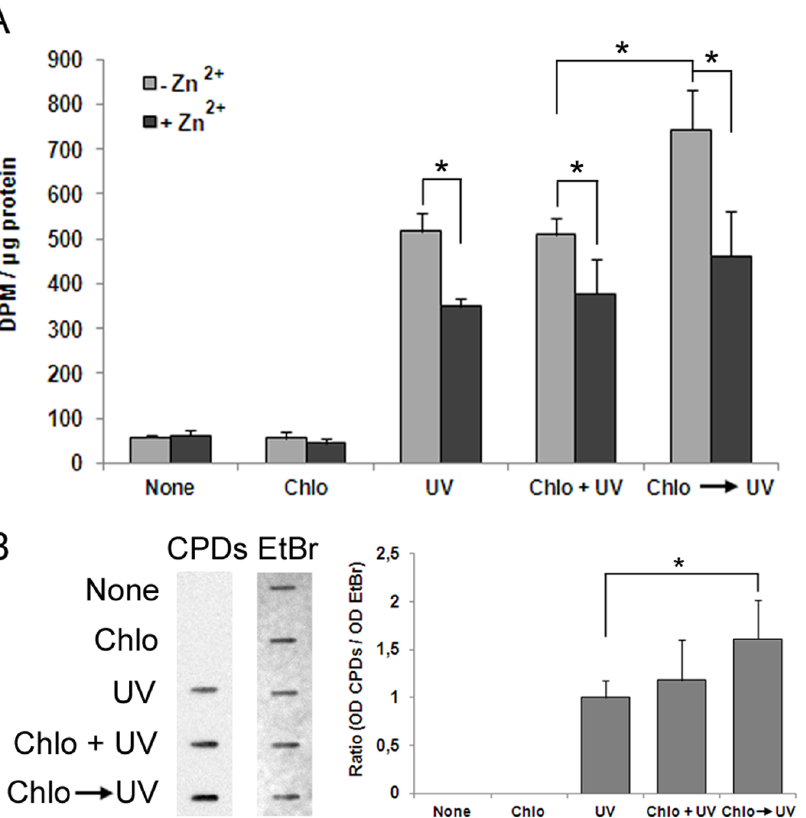
Figure 6. Chloroquine-mediated induction of p19 increases the ability of Neuro-2a cells to repair UV-damaged DNA. A. Stably transfected p19 AS Neuro-2a cells were cultured in a serum free-medium during 24 h, and then incubated with 50 m M ZnSO 4 during 16 h. After this time, cells were treated with 100 m M chloroquine and, simultaneously (chlo + UV) or after 4 h (chlo R UV) irradiated with 40 J/m 2 UV, and incubated with 10 m Ci/ml [ 3 H]thymidine for 10 h. Cell lysates were tested for unscheduled DNA synthesis assay. Bars represent the mean 6 S.D. of three different experiments performed in triplicate. Student’s t -test was used to compare Zn 2 + -treated with non treated samples (* p , 0.05) and to compare chloroquine R UV-treated with chloroquine + UV-treated from stable transfectant samples (* p , 0.05). B. Neuro-2a cells were assayed for the presence of CPD lesions. Stably transfected p19AS Neuro-2a cells were incubated in a free-Zn 2 + medium and treated with 100 m M chloroquine and, simultaneously (Chlo + UV) or after 4 h (chlo R UV) irradiated with 40 J/m 2 UV. Immediately after UV irradiation, cells were harvested, DNA isolated and examined for the presence of CPD lesions by immuno-slot blot using and specific antibody. Ethidium bromide staining was used to ensure equal protein content. Figure shows a representative photograph of three independent experiments. Densitometric analysis of CPD lesions is represented in the right panel. Bars represent the mean 6 S.D. of three experiments performed in triplicate. Student’s t -test was used to compare samples treated with choroquine R UV with samples treated with UV. (* p , 0.05). Chloroquine (Chlo), EtBr (ethidium